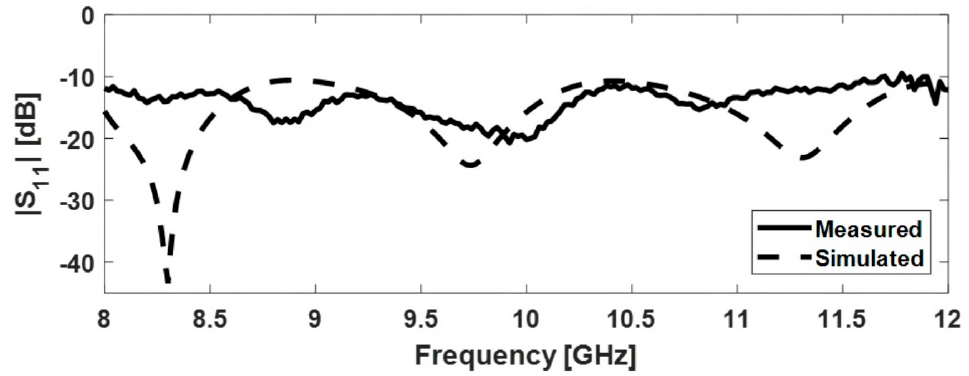
Figure 9. Input reflection coefficient for the pyramidal horn antenna.